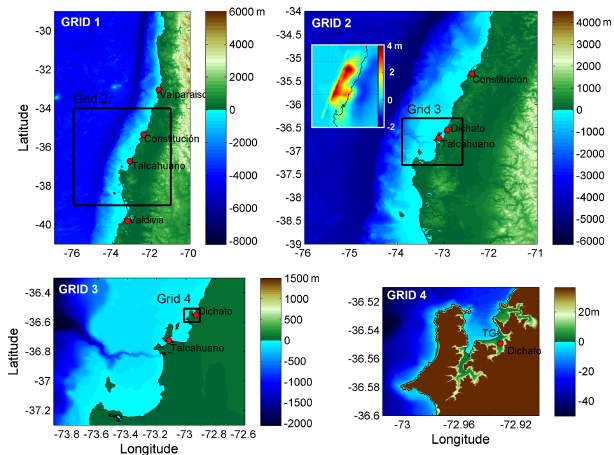
Figure 2. Nested computational grids. The inset in grid 2 shows the tsunami initial condition (Hayes, 2010). TG in grid 4 indicates the location of the virtual tide gauge.